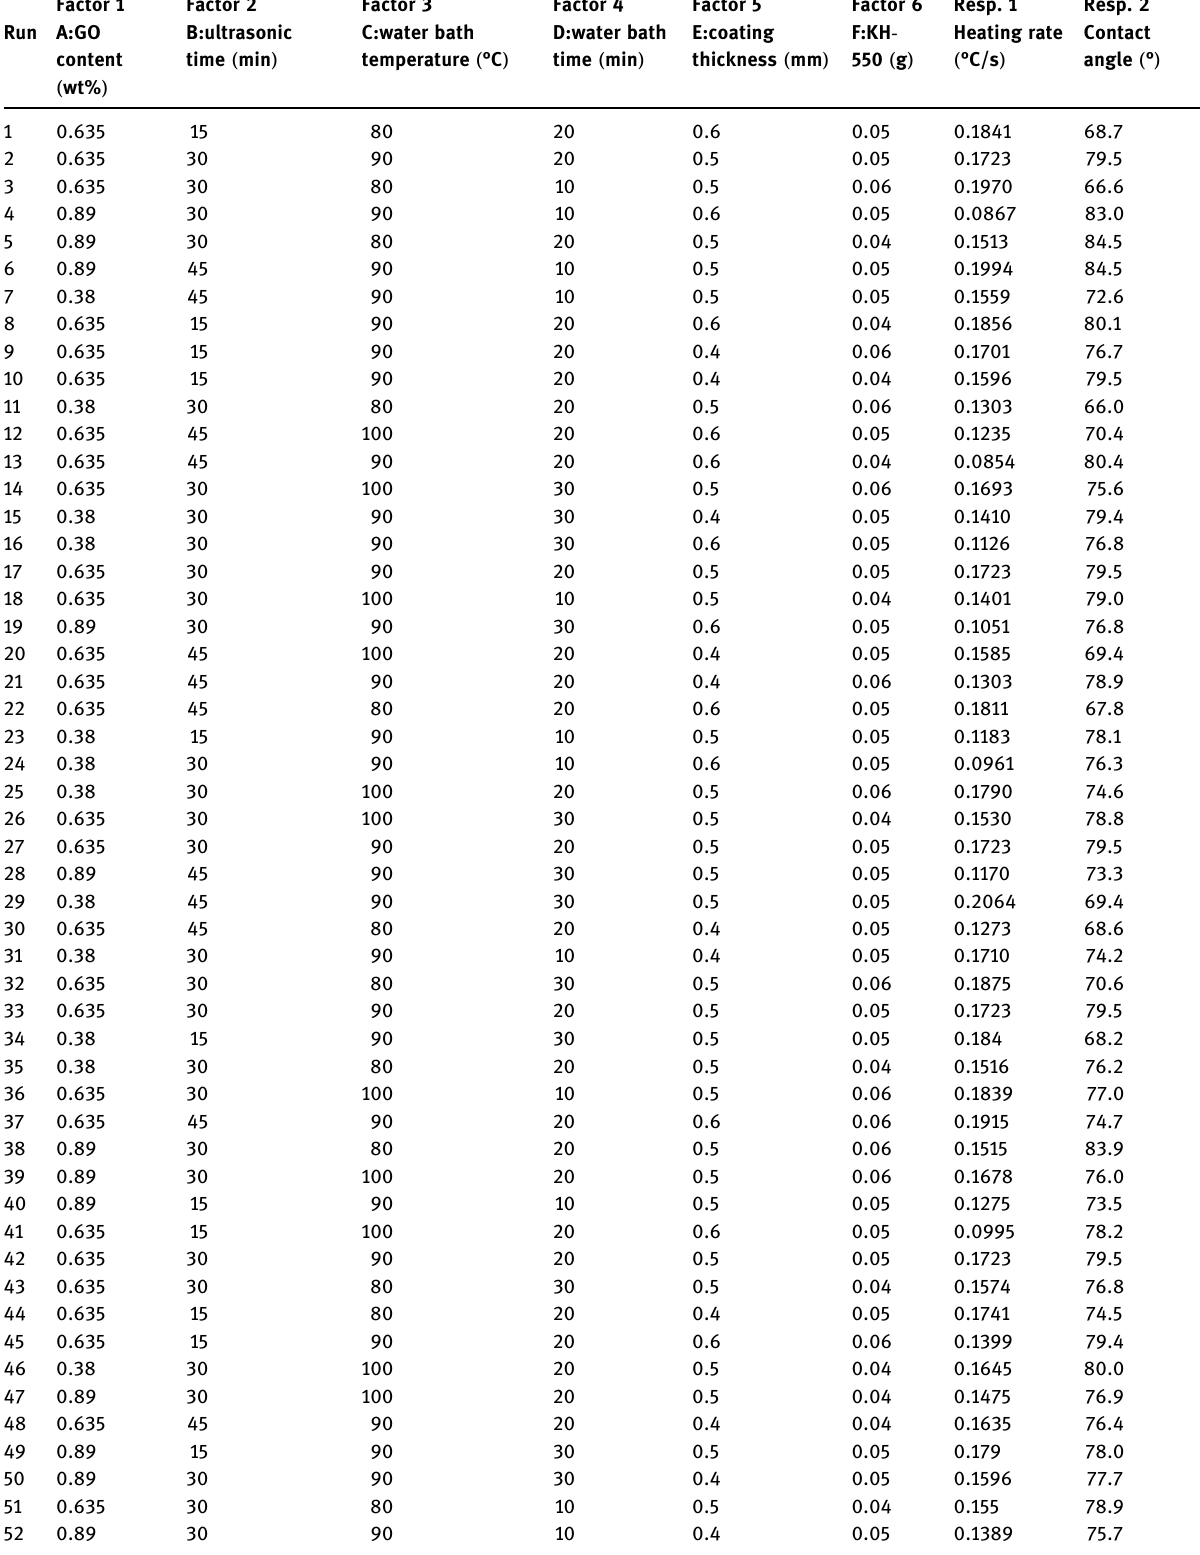
Table 2: BBD matrix and